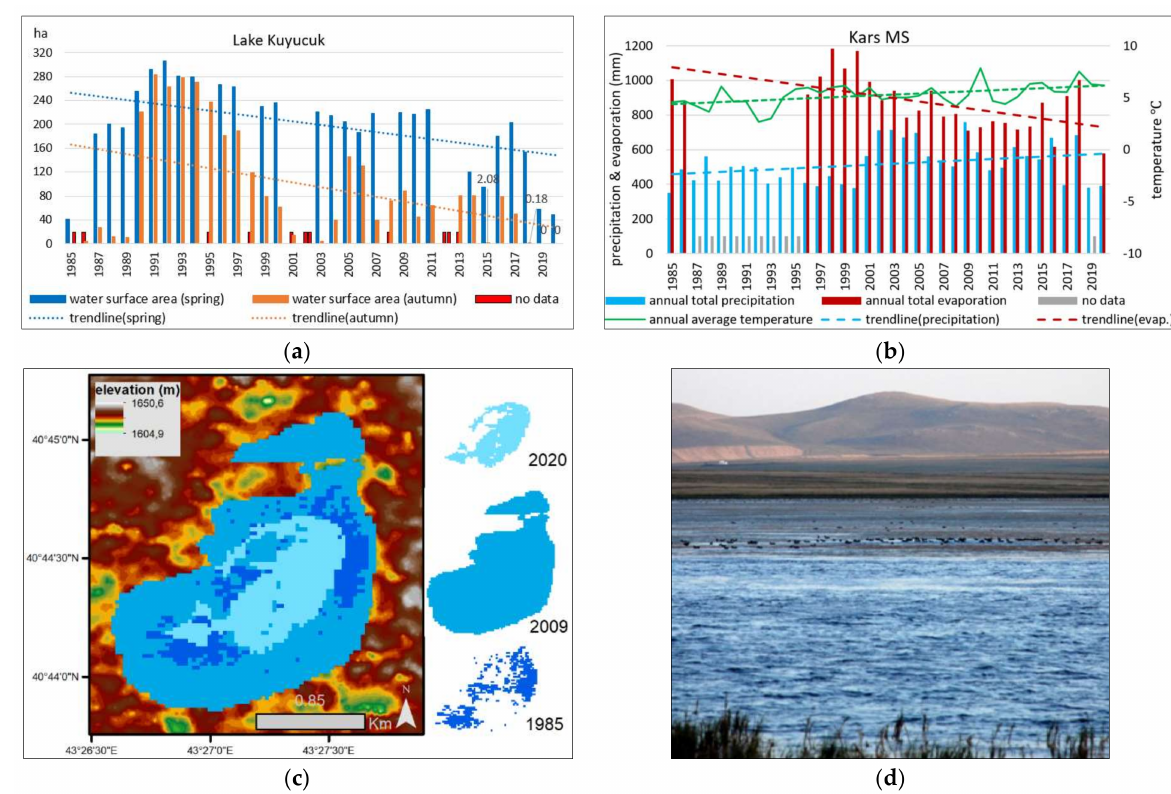
Figure 8. Lake Kuyucuk: ( a ) 1985–2020 annual (spring and autumn) surface water areas; ( b ) representative meteorological station data (precipitation, evaporation, and temperature); ( c ) water surface area changes (NDWI); ( d ) view of the lake